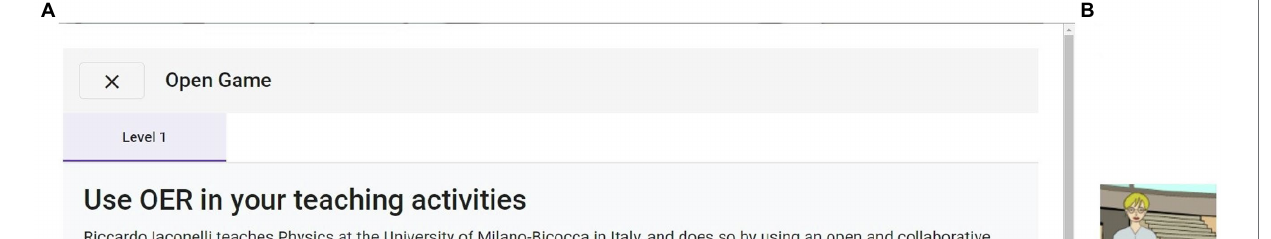
FIGURE 4 | Auditorium A.